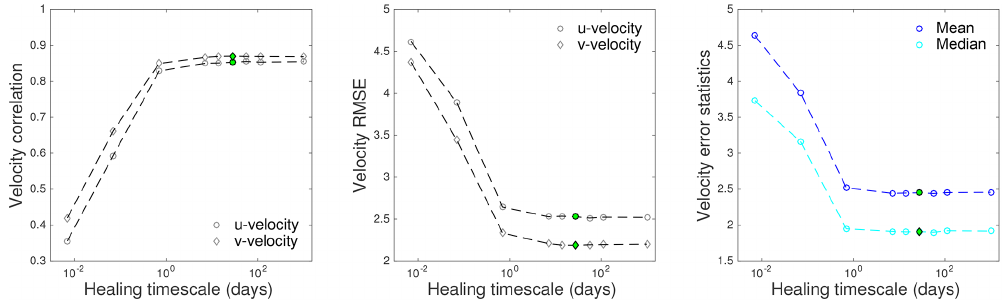
Figure 5. Sensitivity of the velocity statistics to the healing timescale. The left panel shows the correlation between the simulated and observed ice drift, the central panel shows the RMSE and the right panel the velocity mean and median velocity errors. The dots in green correspond to the reference run (28days healing